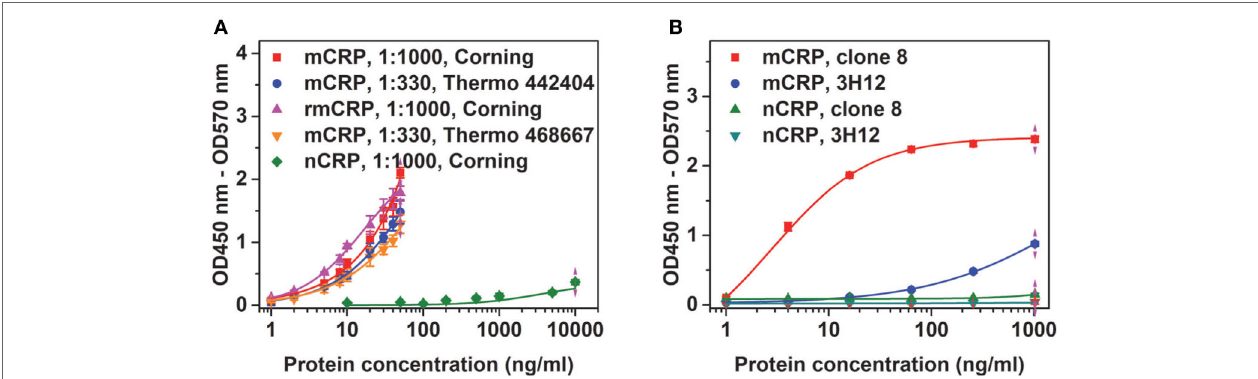
FigUre 1 | Conformation specificity of the assay. (a) Native C-reactive protein (nCRP), monomeric CRP (mCRP), or recombinant mCRP (rmCRP) at the indicated concentrations were added to the indicated wells coated with 1:1,000 or 1:330 CRP-8 mAb, and the captured proteins were detected with a polyclonal CRP antibody from the BindingSite. (B) nCRP or mCRP at the indicated concentrations were added to wells (Thermo Fisher; catalog number: 442404) coated with 1:330 CRP-8 (clone 8) or 1:200 3H12 mAbs, and the captured proteins were detected with a polyclonal CRP antibody from the